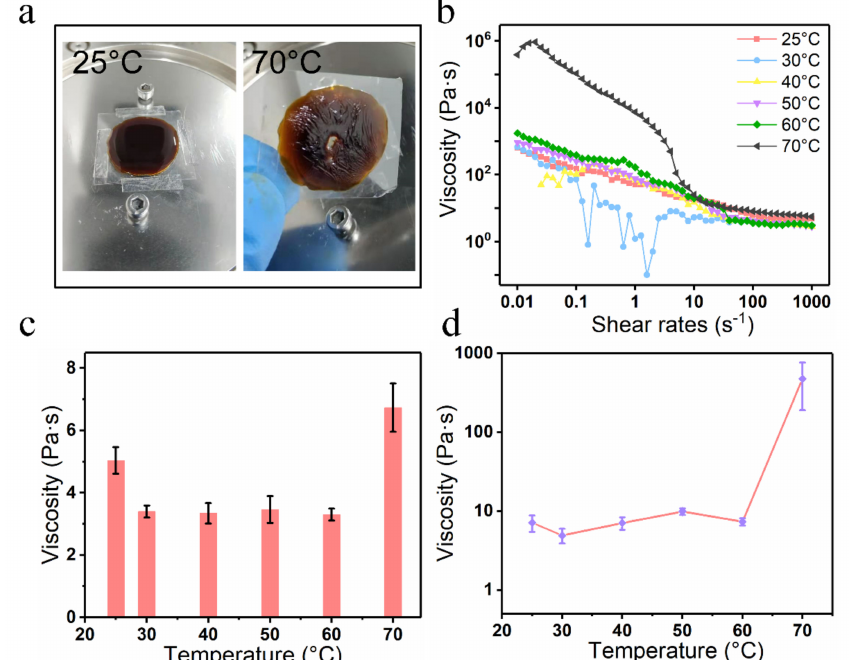
Figure 10. Rheology property of the tobacco extract (liquid) after dilution. The images of tobacco extract ( a ) at 25 ◦ C and 70 ◦ C; ( b ) Viscosity of tobacco extract under different temperature vs. shear rates; ( c ) The mean viscosity changes vs. temperature at shear rate range of 100–1000 s − 1 ; ( d ) Viscosity changes vs. temperature at shear rate of 10 s − 1 .